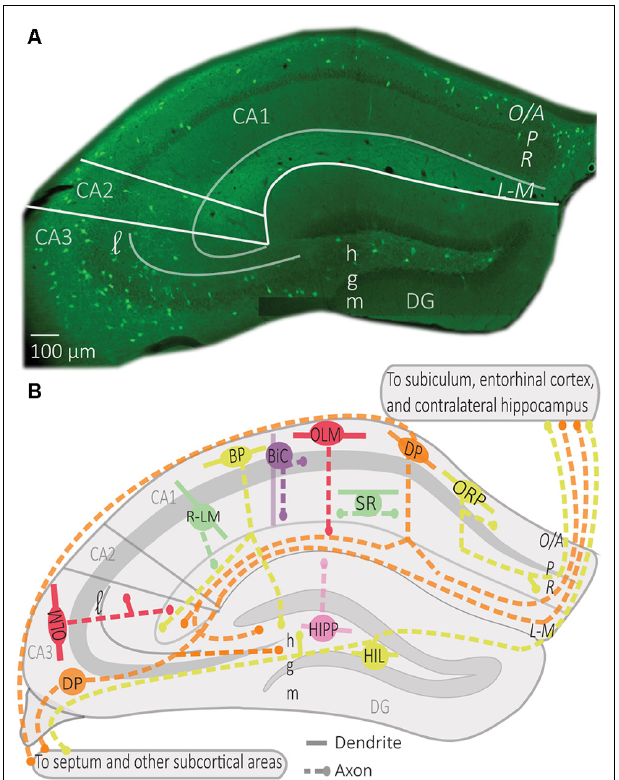
FIGURE 1 | Distribution of somatostatin (SOM) interneurons in hippocampus. (A) Representative montage of fluorescence images showing the soma location of SOM interneurons expressing the enhanced yellow fluorescent protein in the dorsal hippocampus of Sst ires-Cre ; Rosa26 lsl-EYFP mice (Vasuta et al., 2015; Artinian et al., 2019), with indicated anatomical landmarks. (B) Simplified diagram illustrating the characteristic position of soma, dendrites, and axons of the different types of SOM interneurons in hippocampus. Abbreviations for hippocampus: CA1–3, cornu ammonis 1–3; DG, dentate gyrus; O/A, oriens / alveus ; P, pyramidale ; R, radiatum ; L-M, lacunosum-moleculare ; l, lucidum ; h, hilus; g, granule cell layer;